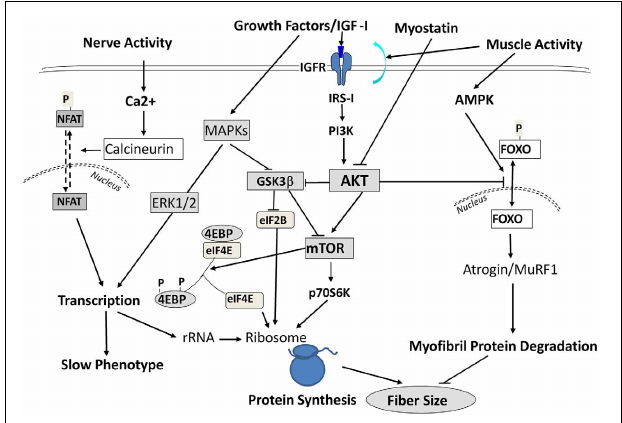
FIGURE 5 | Signaling Pathways Leading to Altered Protein Balance Affecting Muscle Fiber Size. A simplified schematic of signaling pathways affecting protein balance in muscle fibers. Signals are initiated by either growth factors, nerve, or muscle contractile activity and are transmitted into the cells to affect protein synthesis via mTOR/Akt signals, protein transcription via MAPK ERKs, and protein degradation through Foxo/Atrogin/Murf1 action. For further information, the readers are referred to excellent reviews by Sandri (2008); Elkina et al. (2011); Bonaldo and Sandri (2013) and by Frost and Lang